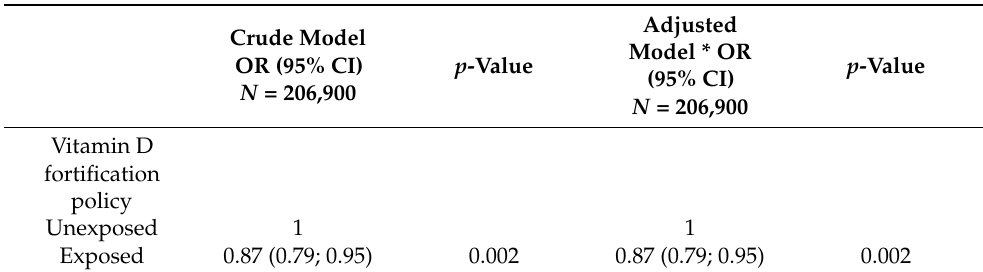
Table 2. Odds of incident IBD according to prenatal exposure to extra vitamin D from the fortification policy, logistic regression with both crude and adjusted